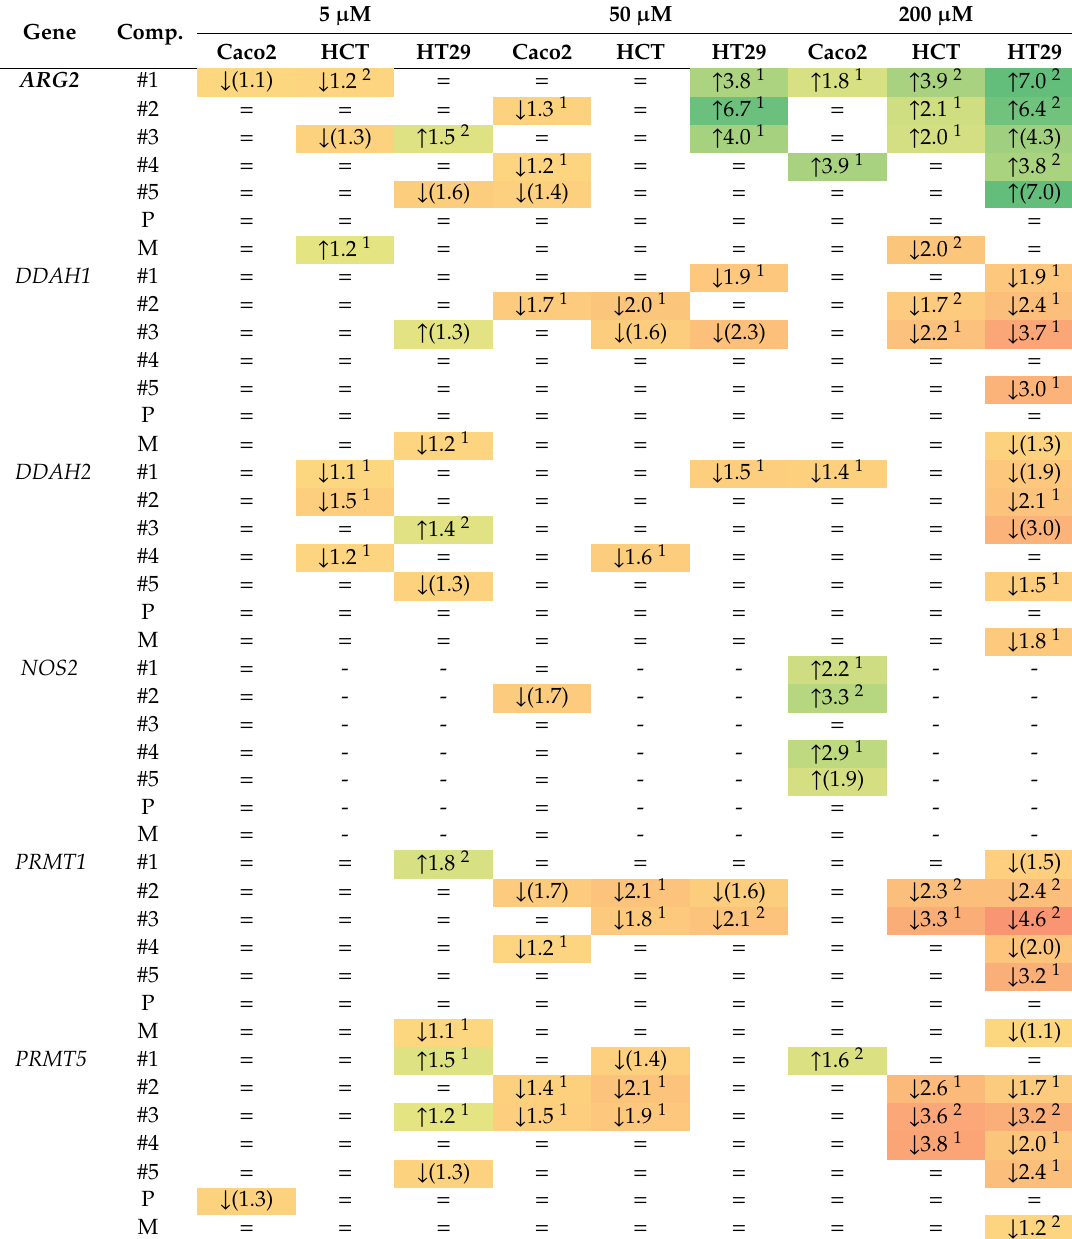
Table 1. E ff ect of novel oxicam analogues on arginine / nitric oxide pathway